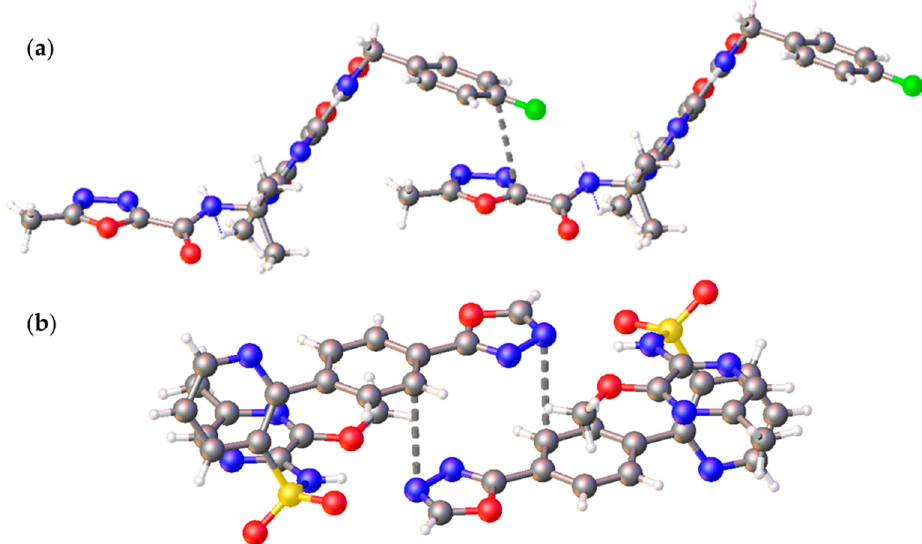
Figure 8. The (oxadiazole) ··· π interactions found in the crystal structures of Raltegravir (CCDC DIRCIS) ( a ); and Zibotentan (CCDC OCAGAB) ( b